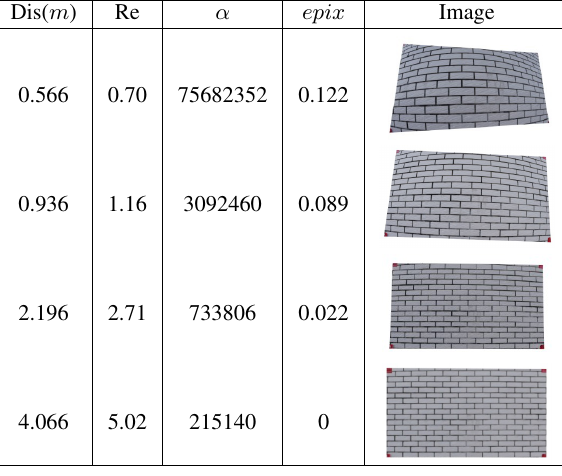
Table 1. Experiment data of Distance Clarity